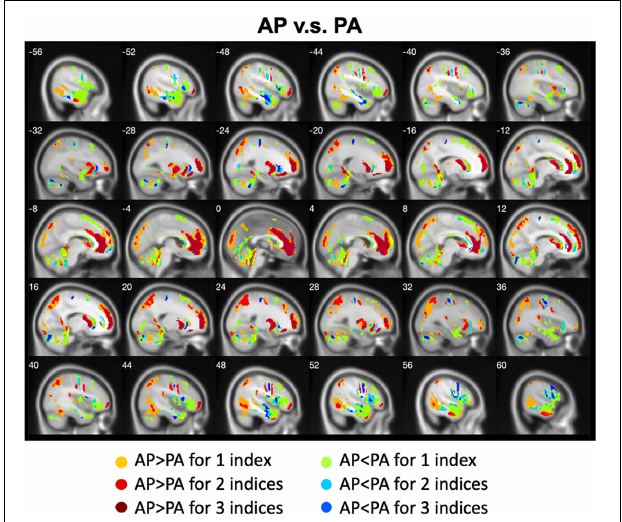
FIGURE 2 | Overlapped regions that showed different local spontaneous brain activity (i.e., ALFF, fALFF, and ReHo) depending on PE direction (AP vs. PA). Dark red indicates common regions for all the three indices where the AP direction exhibited significantly higher brain activity than the PA direction. Light red indicates common regions for any two indices where the AP direction exhibited significantly higher brain activity than the PA direction. Dark blue and light blue indicate the reverse.